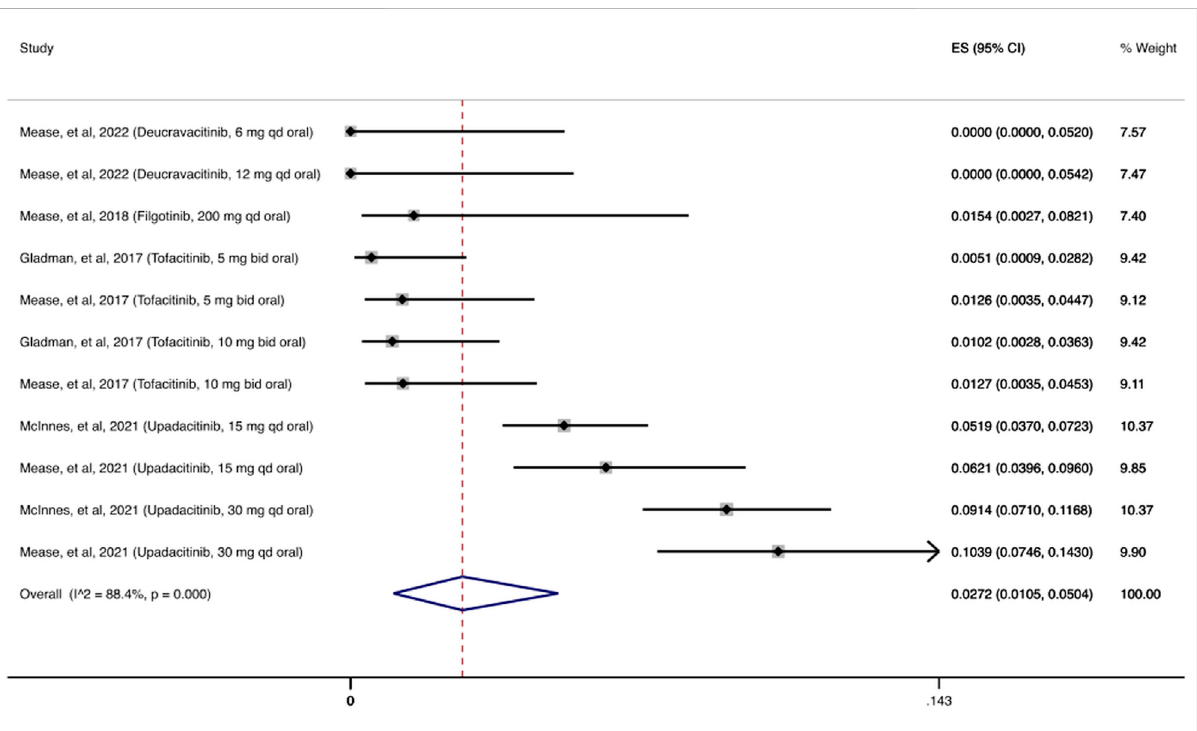
FIGURE 2 OpportunisticinfectionscumulativeincidenceforJAKinhibitorsduringRCTsandtheirextensionperiods.Individualandcombinedestimatesof the cumulative incidence of opportunistic infections for patients treated with JAK inhibitors with 95% con fi dence intervals. ES: Effect Size (Cumulative